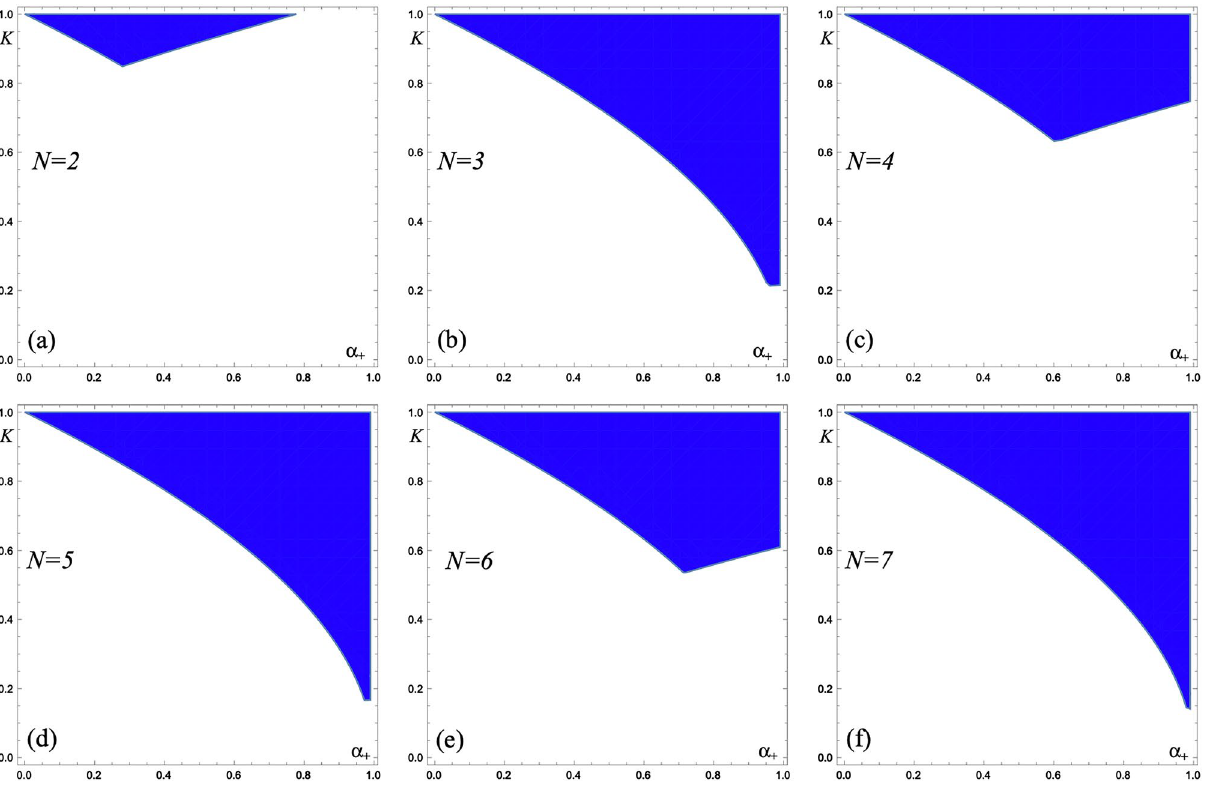
Figure 1. The phase diagram for a set of N Kramers doublets under repulsive density–density interaction. The blue regions represent stable SC